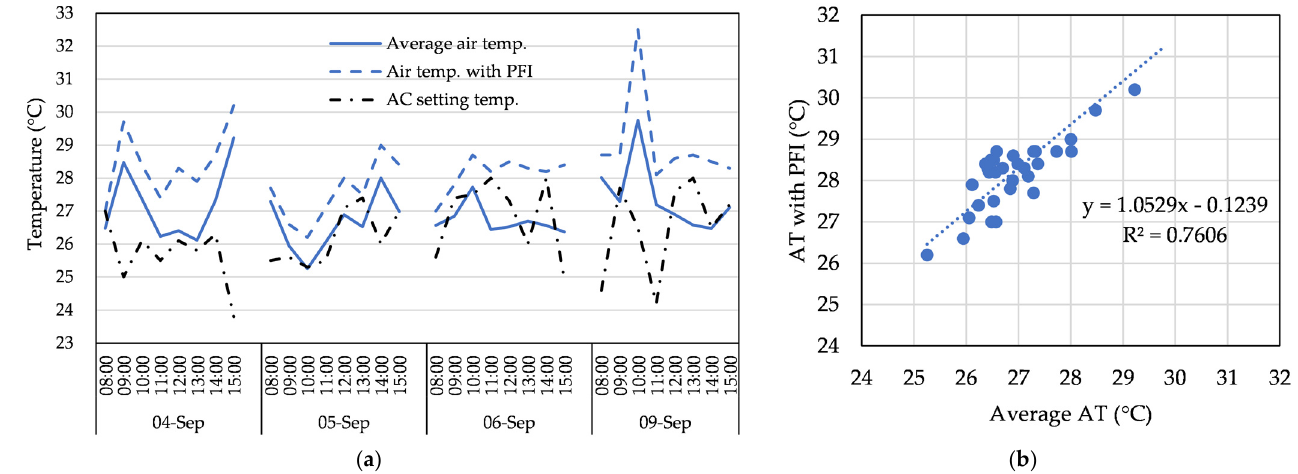
Figure 22. Summer indoor air temperature and correlation for the ( a ) summer average AT, AT with